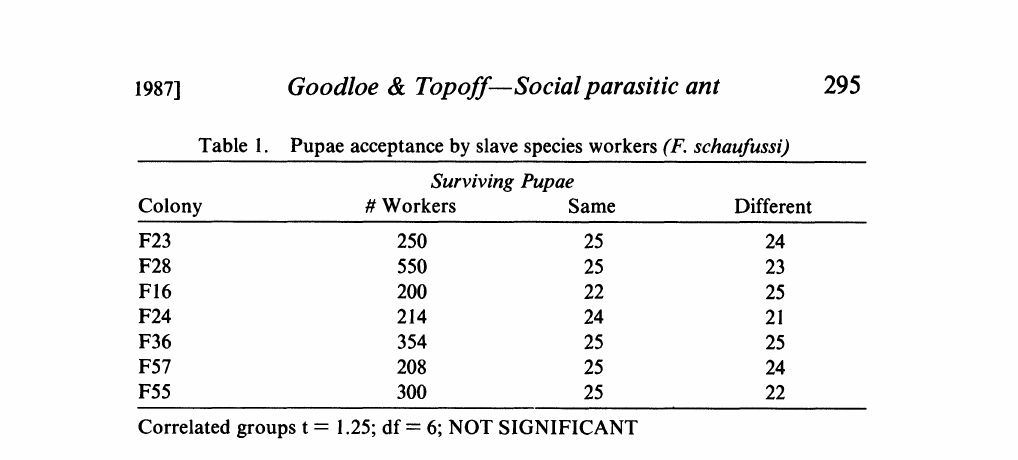
Table 1. Pupae acceptance by slave species workers (F. schaufussi) Surviving